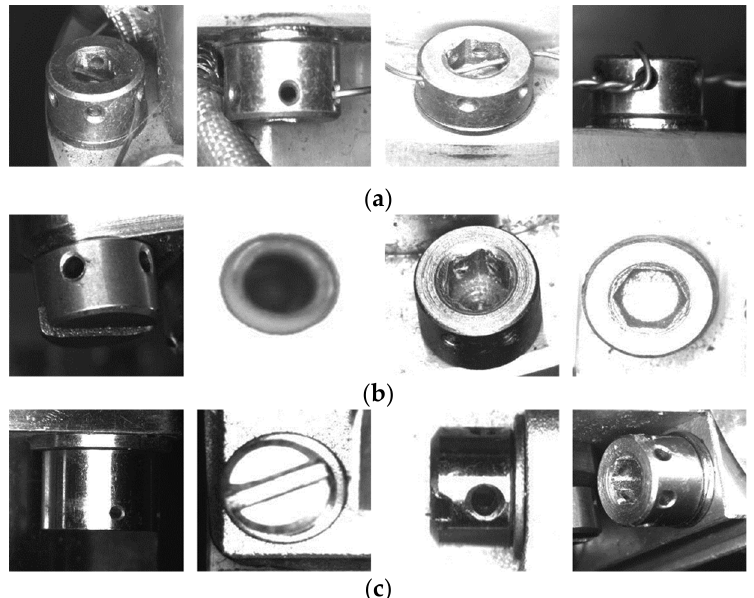
Figure 6. Examples of three classes of the dataset: ( a ) qualified; ( b ) missing lead seal and gasket; ( c ) missing lead seal.